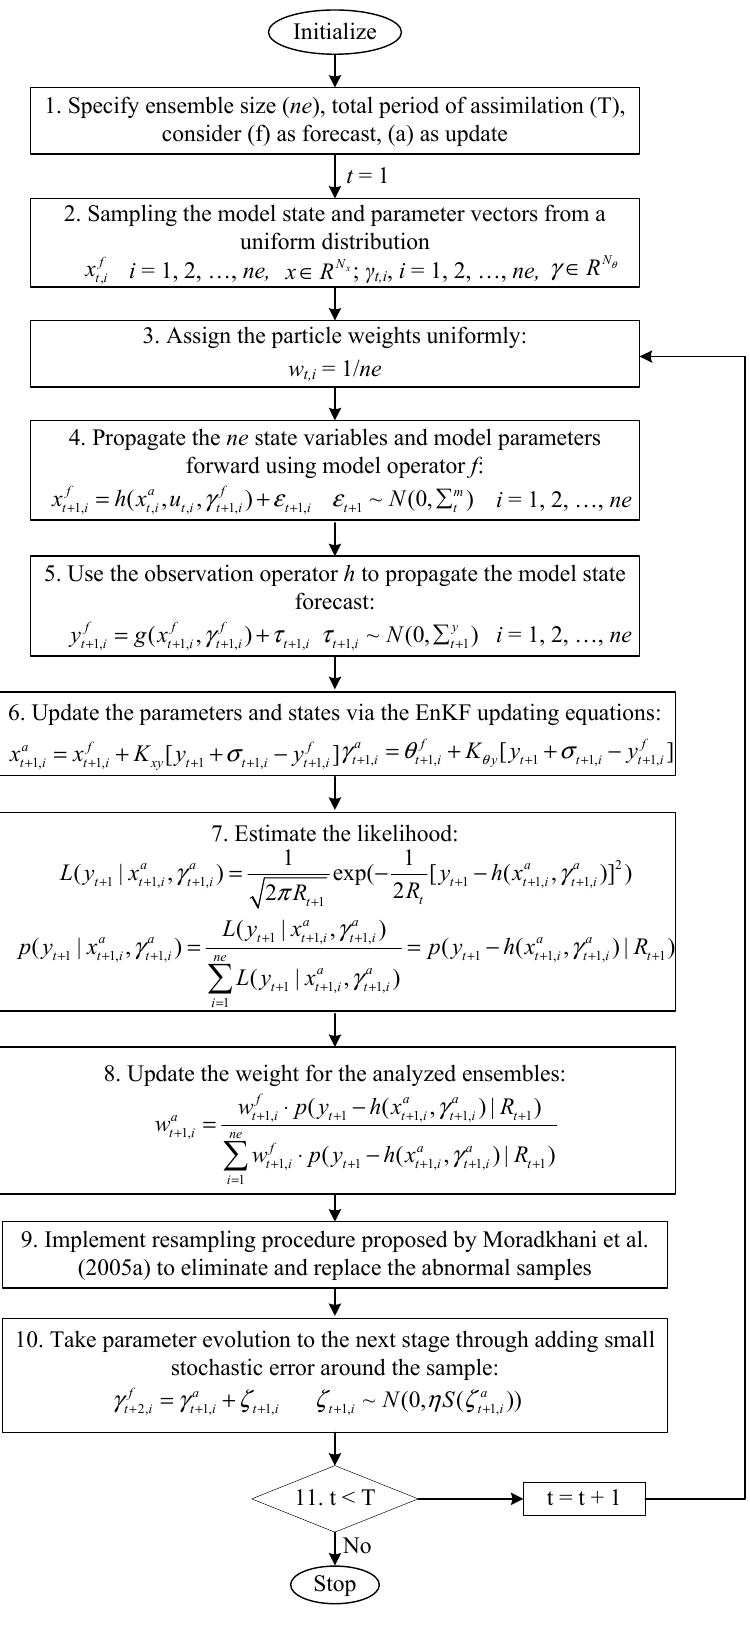
Figure 1. The flow chart of the nested ensemble filtering method.